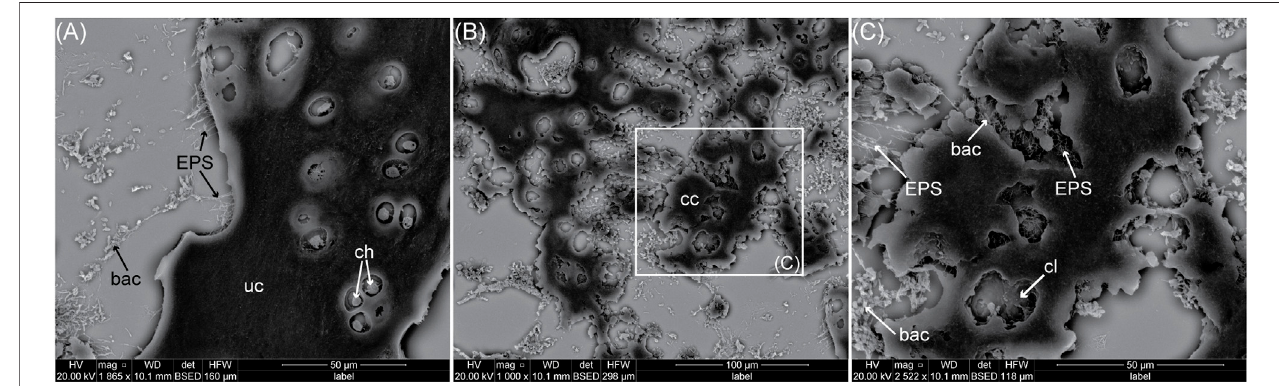
FIGURE 5 | SEM images (on a gold-sprayed and deparaf fi nized slide) of a bio fi lm invasion in decaying avian cartilage in water for 2 weeks. (A) Bacterial bio fi lm on top of uncalci fi ed cartilage (uc). The bacteria (bac) are secreting a sheath of fi lamentous EPS. The more internal chondrocytes (ch) are intact and not invaded by the bio fi lm. (B) Image in the same sample but within some of the calci fi ed cartilage (cc). The cc has been extensively dissolved. (C) Close -up on the dissolved cc showing calcospherites and chondrocyte lacunae (cl) with altered shape. The bacteria and their EPS are in fi ltrating into the gaps of the dissolved ECM. What caused the dissolution of the calci fi ed ECM is unclear. No clear chondrocyte is visible in these lacunae, meaning they underwent autolysis and/or bacterial